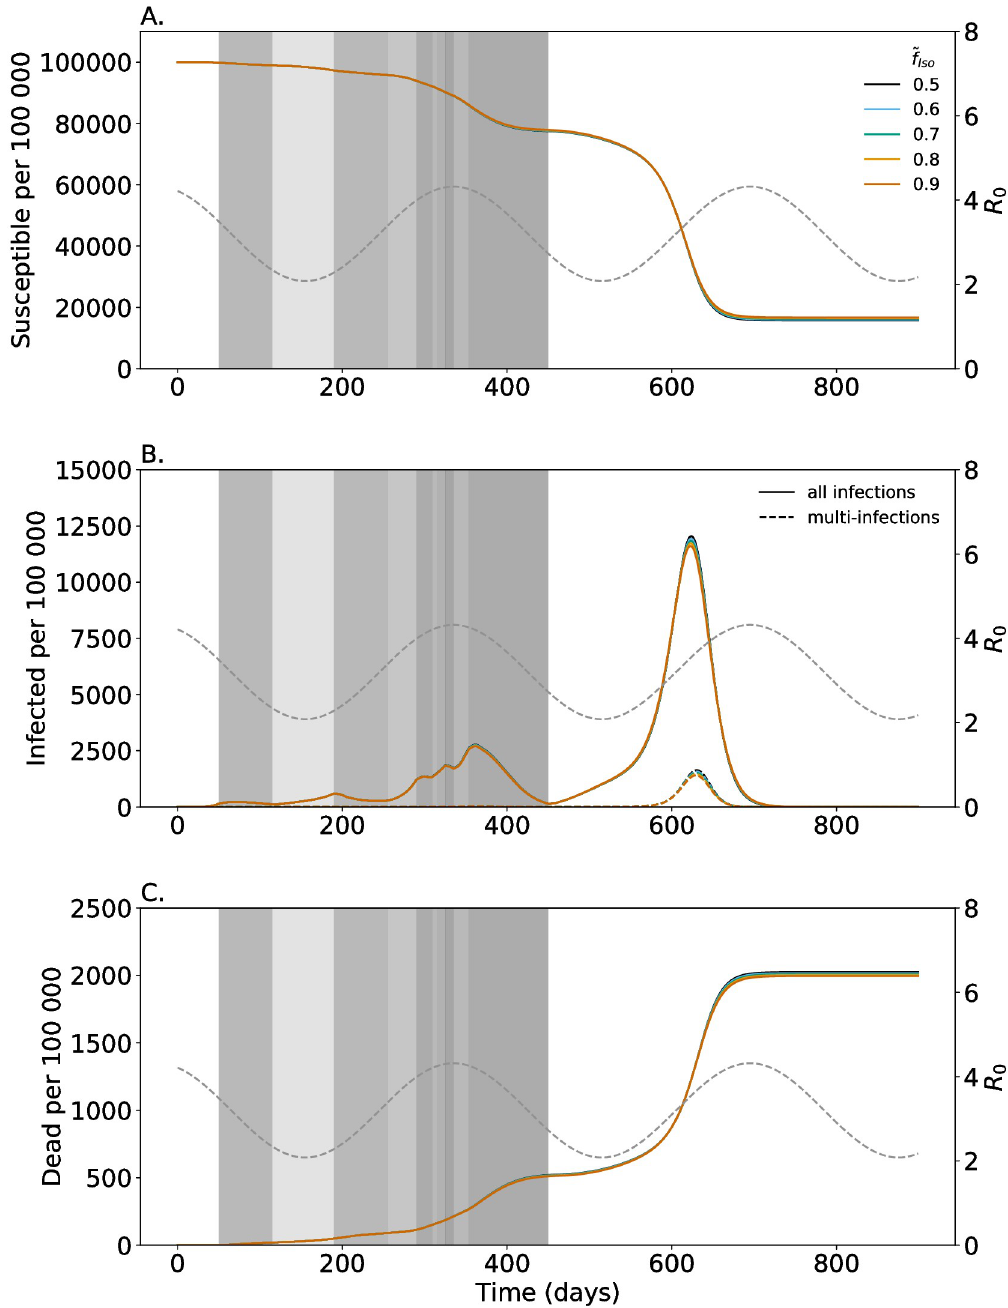
Fig 3. Proportion of symptomatic multi-infections getting isolated. As in Fig 2 but for different values ~ f individuals that become isolated (colors).